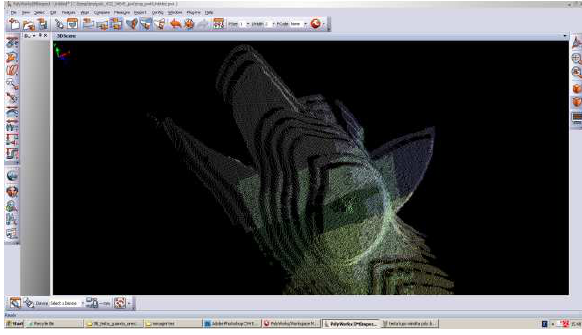
Figure 13. The merge of 5 VIVID 300 scans for the Wolf of